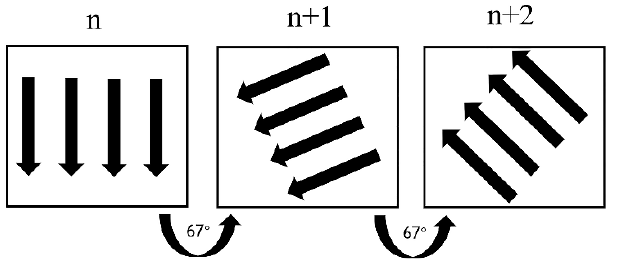
Figure 3. Scanning